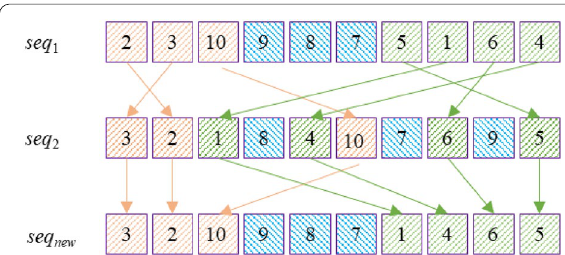
Figure 3 A schematic diagram of module-based crossover neighborhood